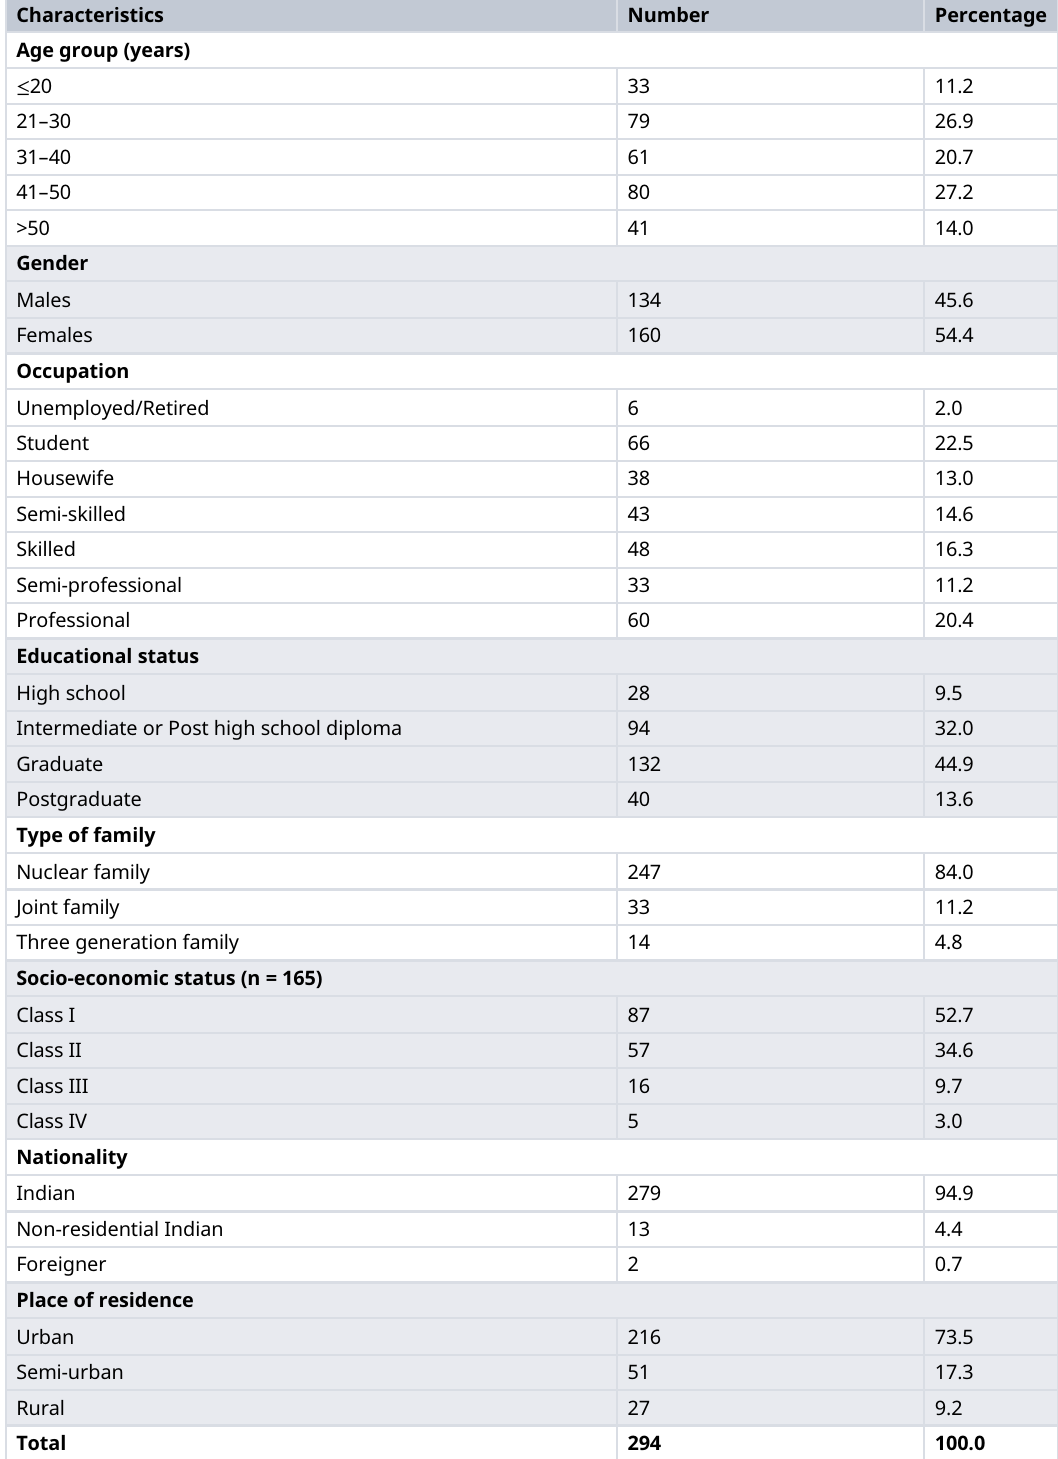
Table 1. Sociodemographic distribution of study participants.